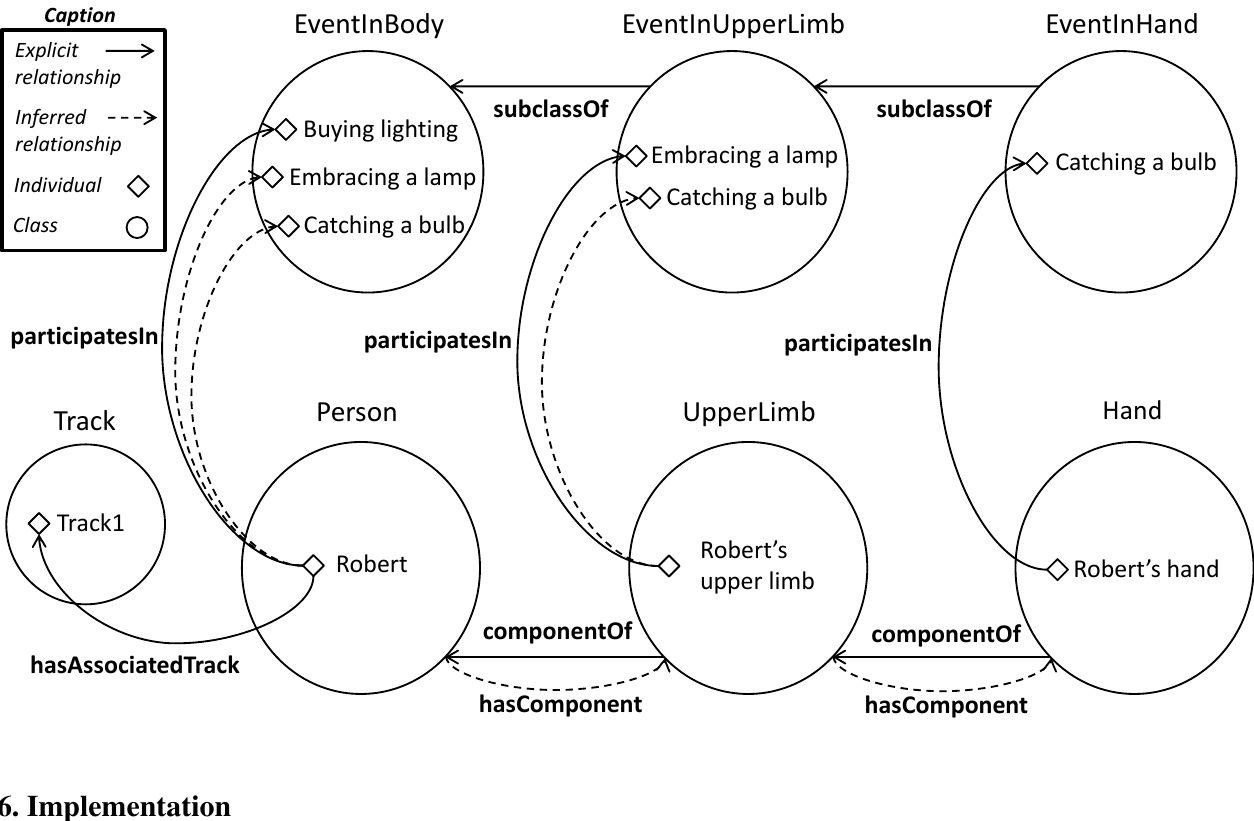
Figure 8. Inferred properties using composition between hasEvent and partOf